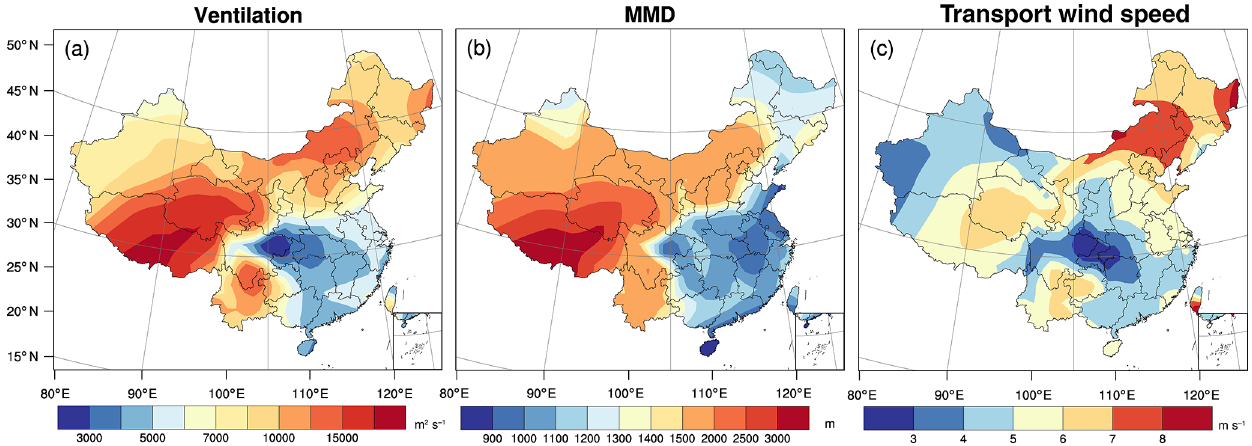
Figure 3. The spatial distribution of daily maximal ventilation (a) , MMD (b) , and transport wind speed (c) averaged over 30 years (1985–